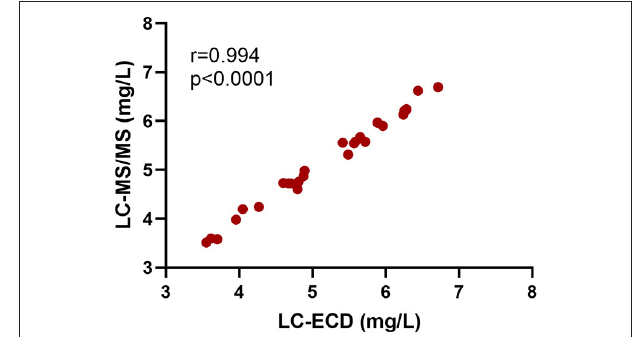
FIGURE 1 | Positive relationship of glucosamine concentrations in hydrolyzed commercial chitin and chitin extracts of different insect exuviae measured by LC-ECD and LC-MS/MS (Pearson’s correlation, r = 0.994, p < 0.0001, N = 27). The samples were diluted 50x in both measurements.